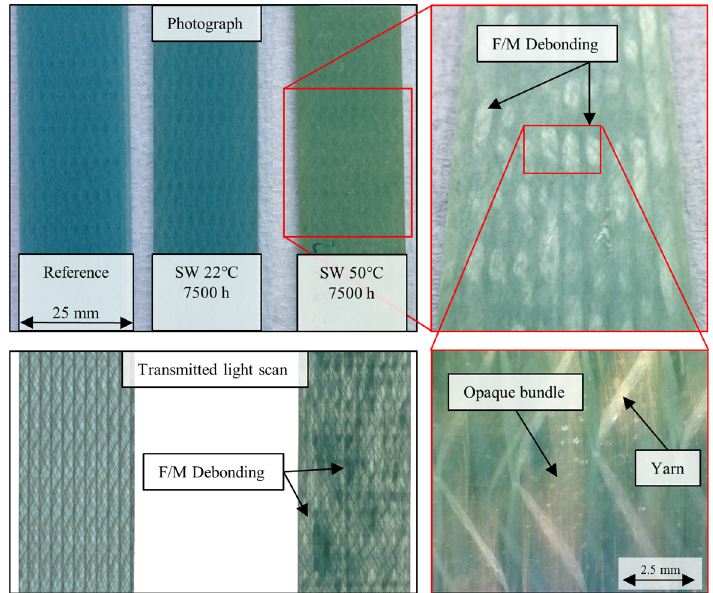
Figure 4. Comparative photographs and transmitted light scans of specimens unaged and after 7500